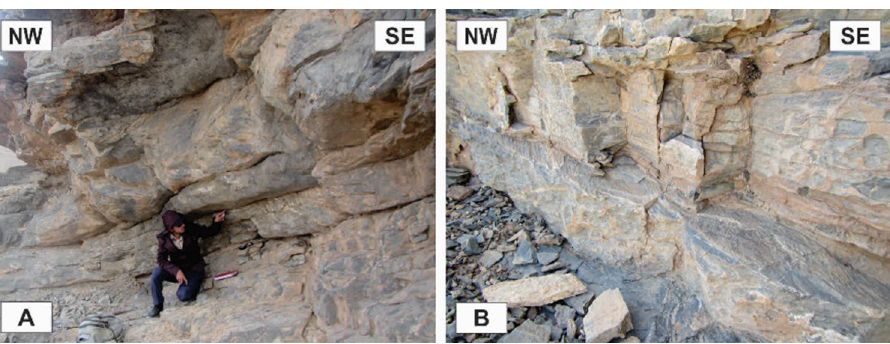
Figure 14. The slickensides on the contacts’ surfaces of the tilted layers in the limbs of the map-scale folds. (Photos are taken by Mohammad Ali Ghanbarian).